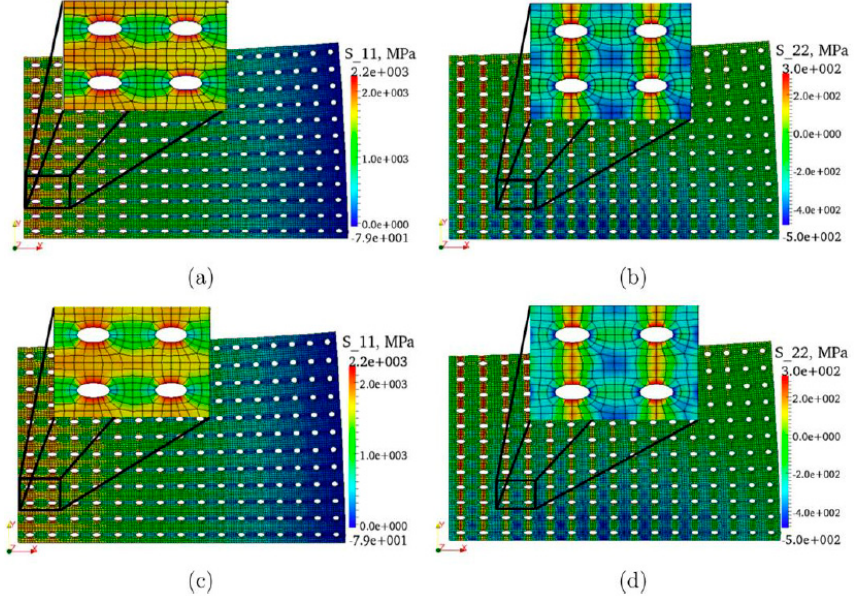
Figure 25. Micro and macroscopic stress distributions for a voided matrix in 2D by means of the proper generalized decomposition. Figure taken with permission from [135]. generalized decomposition. Figure taken with permission from